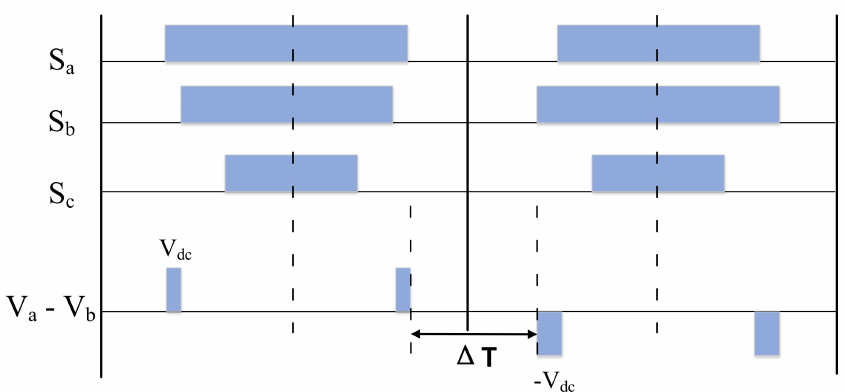
Figure 7. Zero-voltage time interval between line-to-line voltage pulse reversals in SVPWM. As for the TSPWM, the voltage-time interval ∆ T can keep large in both the low and high modulation factor region, which is shown in Figure 8a,c. However, the ∆ T can be zero when the modulation factor equals 0.61. The overvoltage caused by the zero-voltage time interval is dangerous for the vehicular electric drive system.